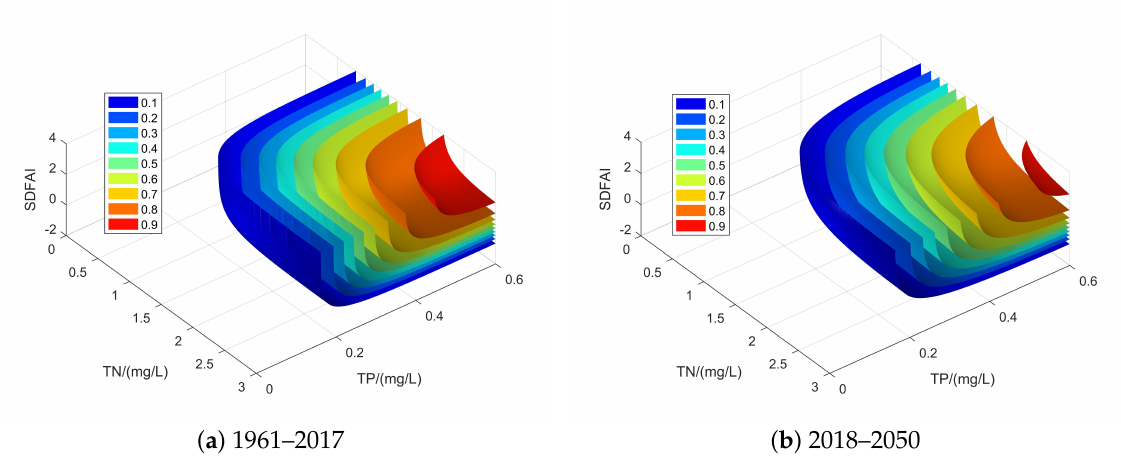
Figure 7. Joint transcendental probability section diagram. Table 4. The possibility of different trivariate combination